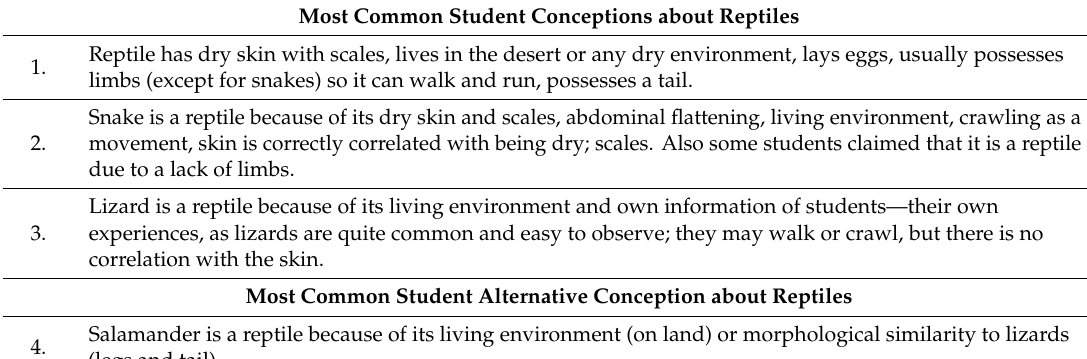
Table 2. Examples of conceptions which arise from answers before intervention about reptiles. Most Common Student Conceptions about